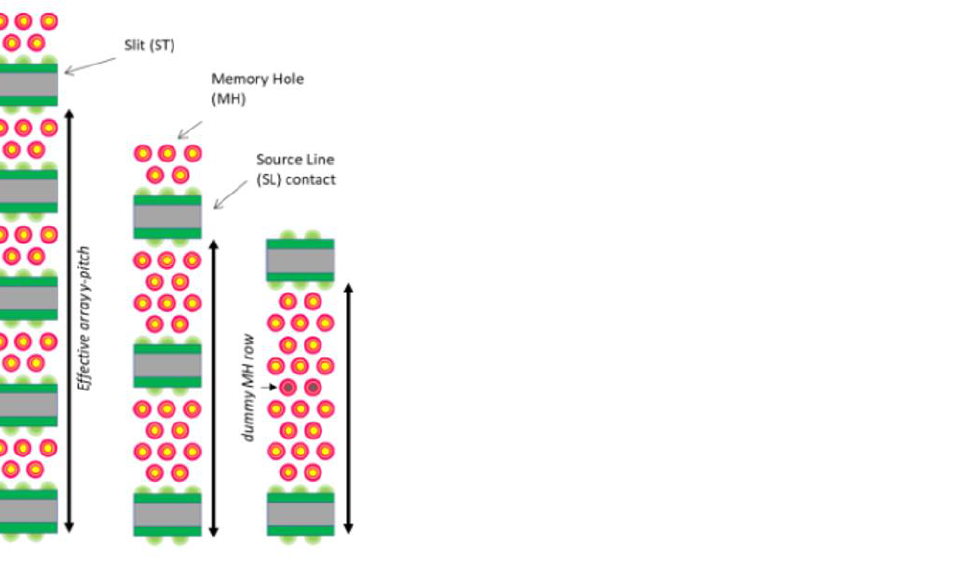
Figure 11. XY scaling by pillar (memory hole) layout efficiency improvement. The pillar layout ap- proaches HPC configuration. Reprinted with permission from ref. [40], Copyright 2020 IEEE. approaches HPC configuration. Reprinted with permission from ref. [41], Copyright 2020 IEEE.